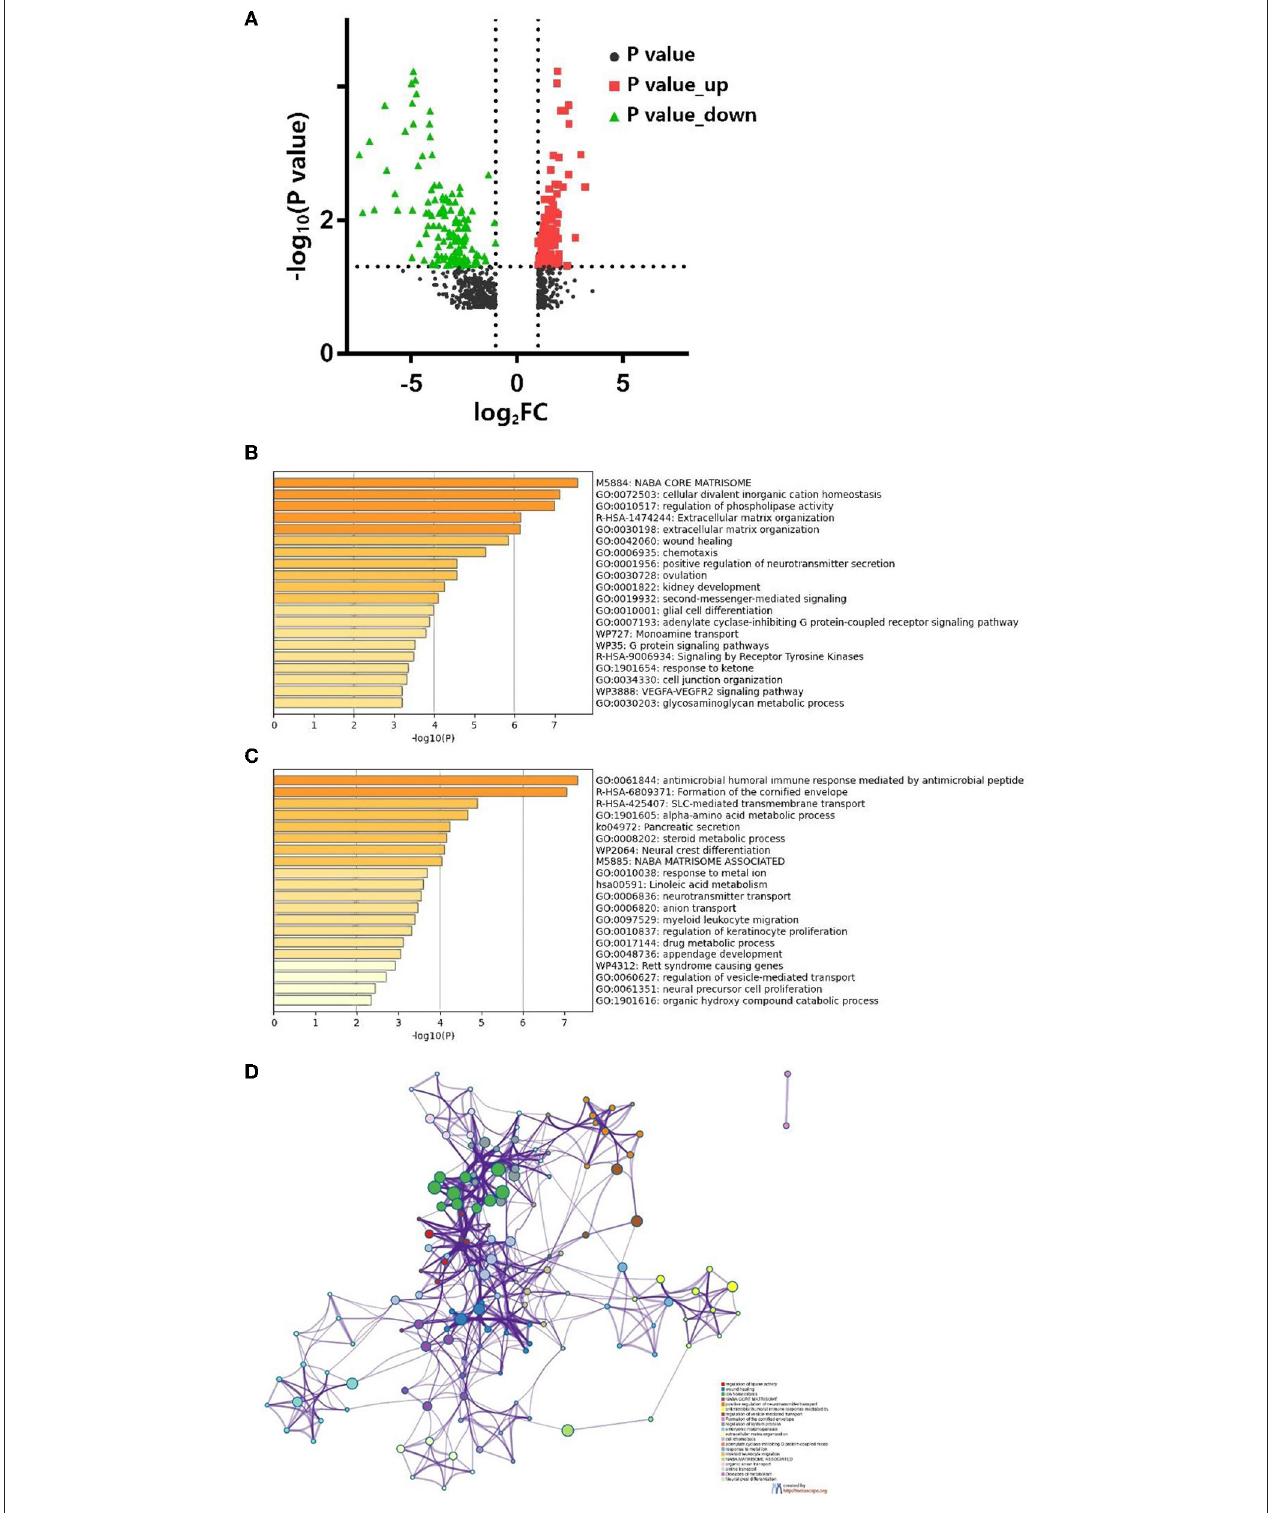
FIGURE 4 | (A) Volcano map of differentially expressed genes. Bar graph of enriched terms across differentially expressed genes are shown for (B) up-regulate, (D) down-regulate, and (C) network of enriched terms colored by cluster ID, each node represents an enriched term. Nodes that share the same cluster ID are typically close to each other and terms with a similarity > 0.3 are connected by edges.